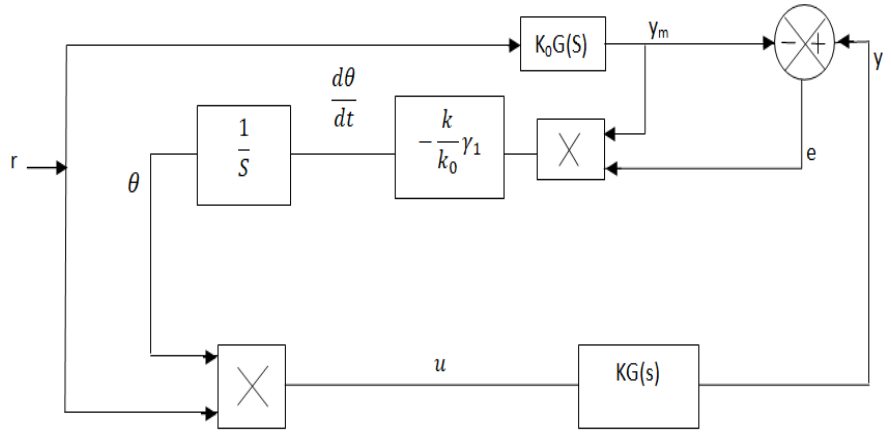
Figure 8. MRAC model to control oxygen concentration for acute respiratory distress patients.